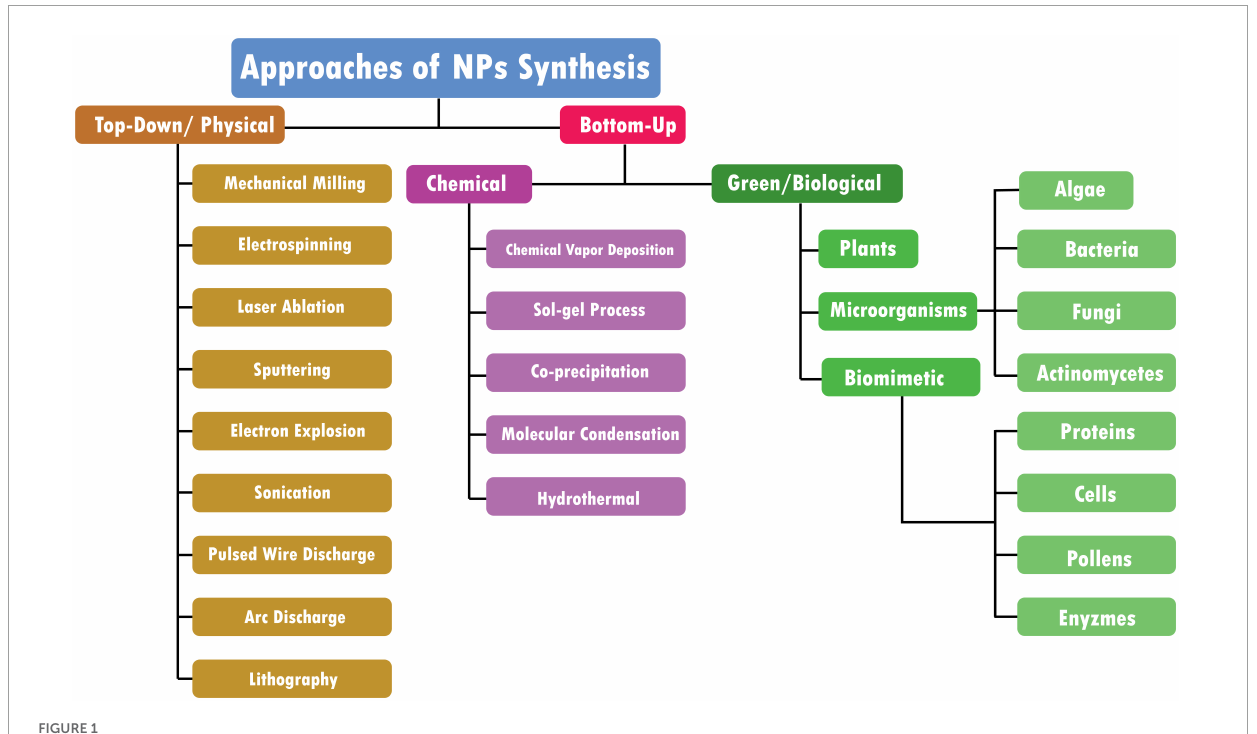
FIGURE1 Approaches of NPs